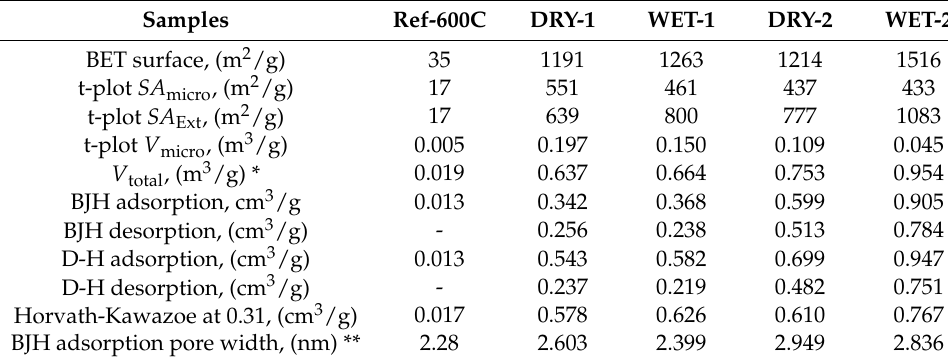
Table 2. Textural properties of the carbonized